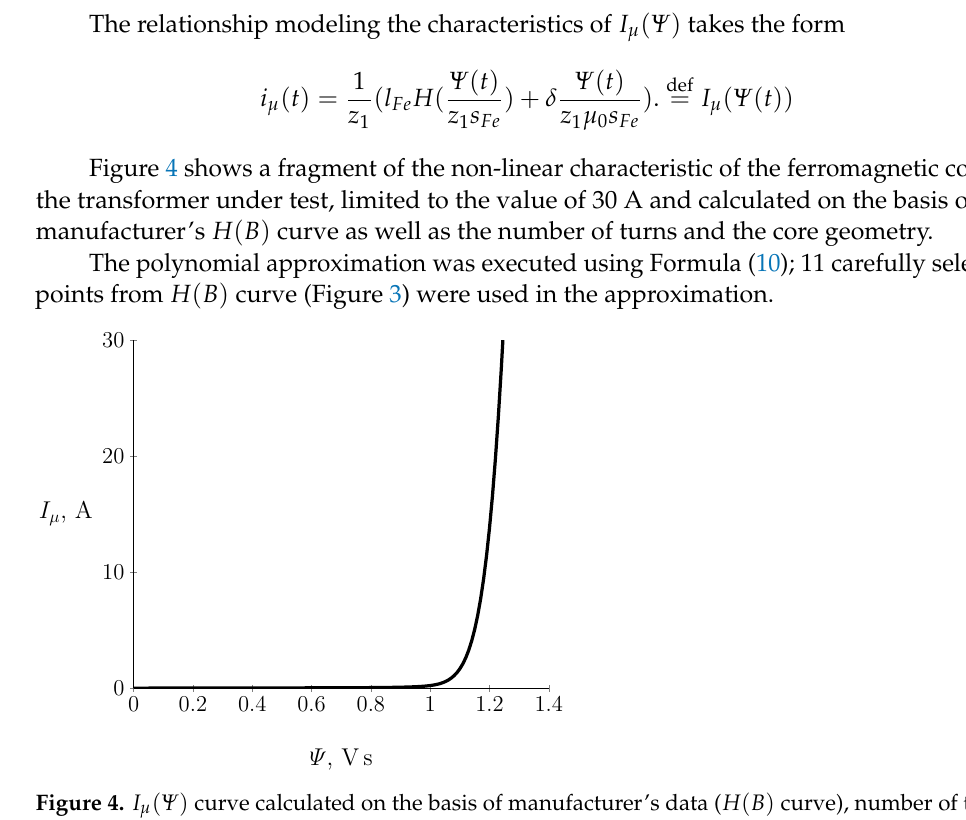
Figure 4. I µ ( Ψ ) curve calculated on the basis of manufacturer’s data ( H ( B ) curve), number of turns, and core